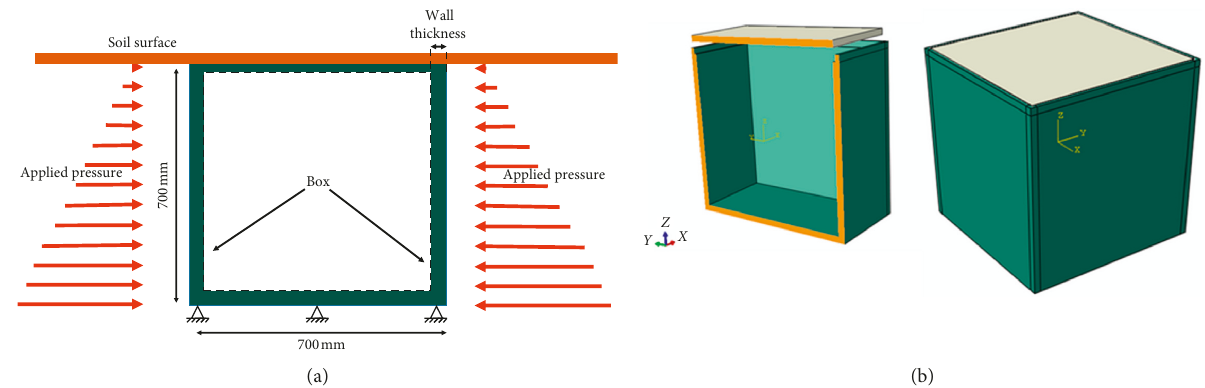
Figure 4: Schematic representation of the polymer concrete underground utility structure simplified as a cubic box: boundary and loading conditions.